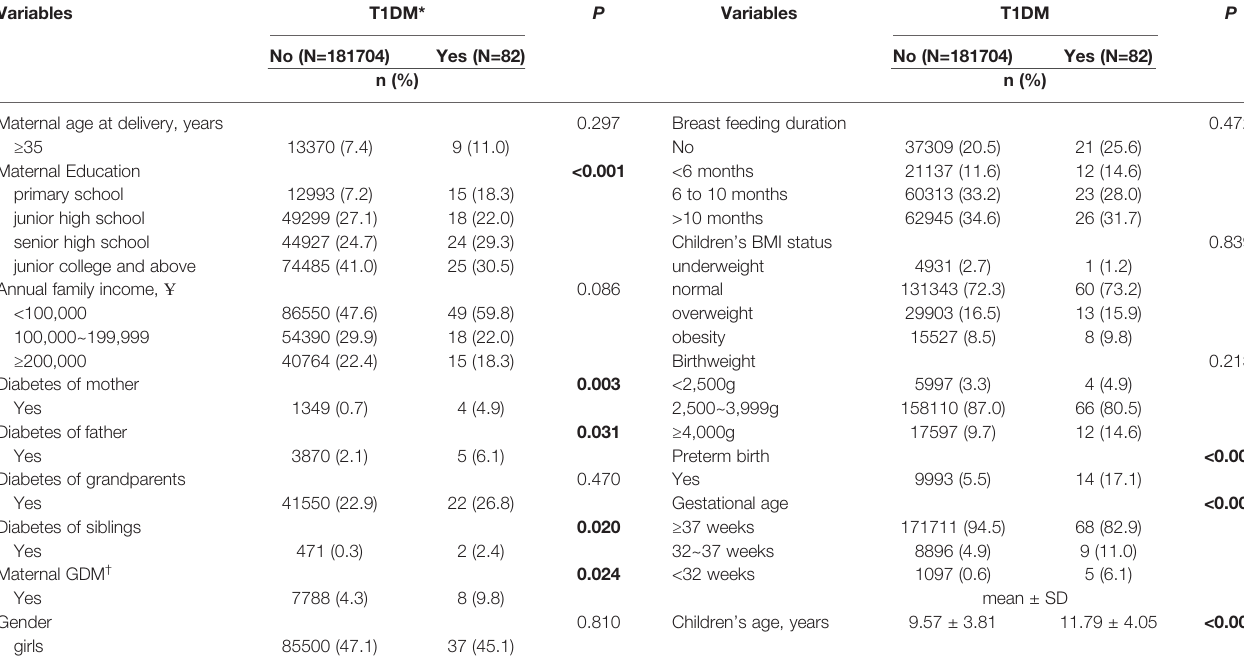
TABLE 1 | Comparison of characteristics between children with and without